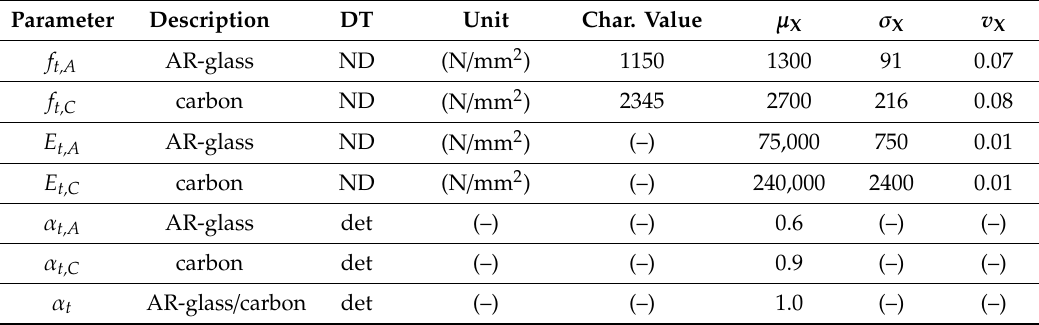
Table 6. Overview of the textile properties—description of the stochastic model for the basic variables.